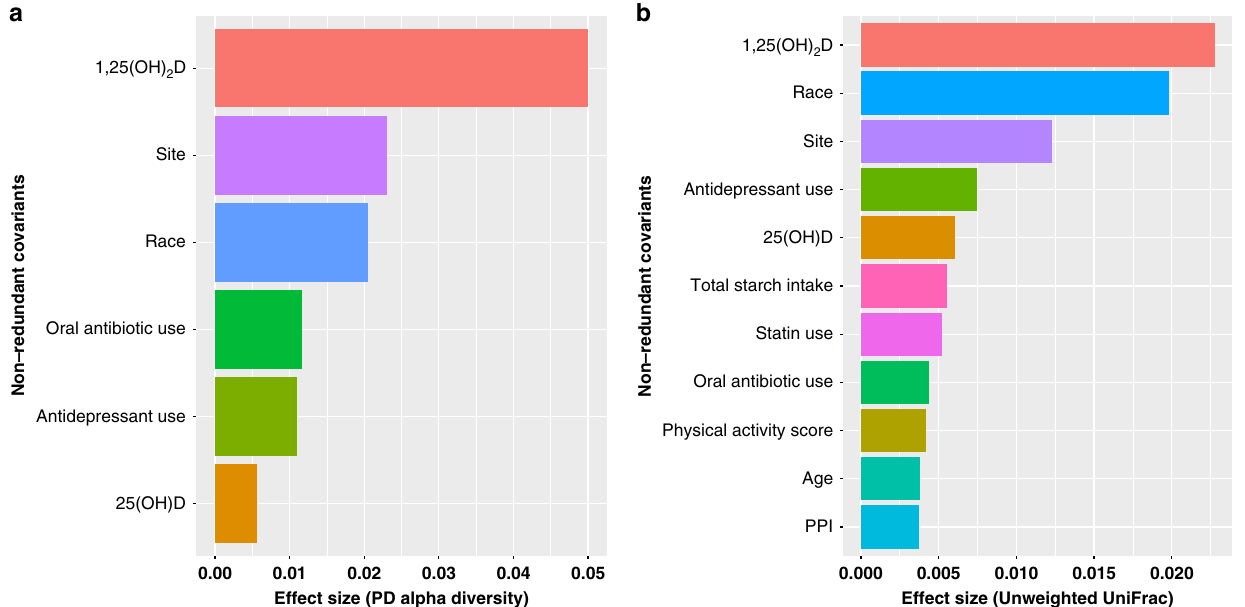
Fig. 2 1,25(OH) 2 D levels explain the highest proportion of the variance in α -diversity and β -diversity. Forward stepwise redundancy analysis (RDA) of non-redundant variables explaining variation in α -diversity ( a ) and β -diversity ( b ) among candidate covariates that included age, site, race, body mass index, vitamin D metabolites, vitamin D activation/catabolism ratios, health behaviors, medications, and dietary intake of resistant starches. Source data are provided as Source data fi le: “ sourcedata_ fi gure2a.txt and sourcedata_ fi gure2b.txt ” .